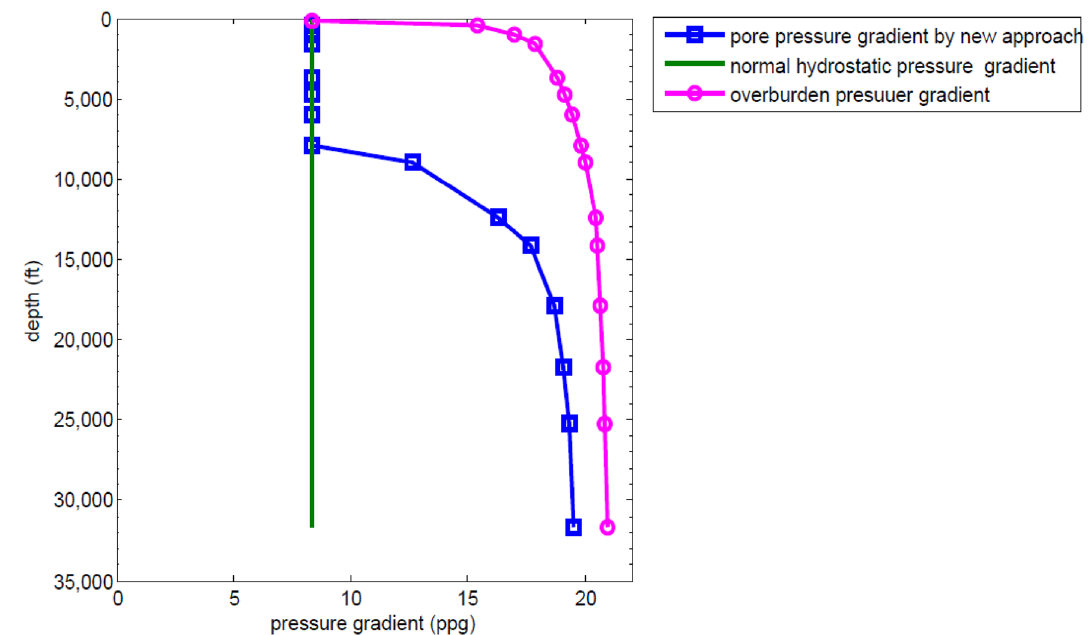
Fig. 10 Pore pressure gradient by the new method